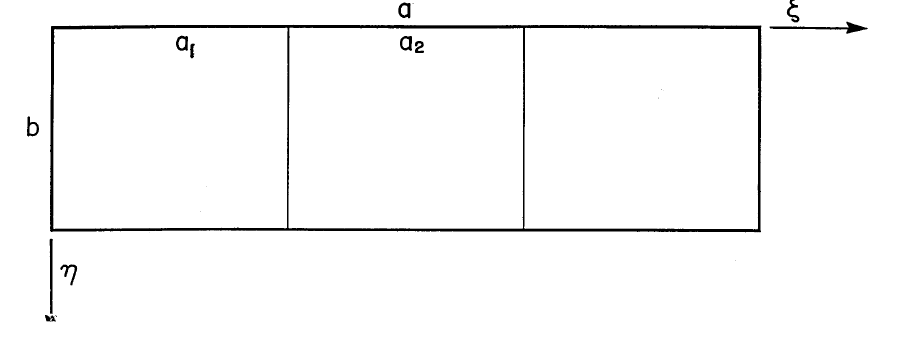
Fig. 1. Schematic representation of 3-span bridge